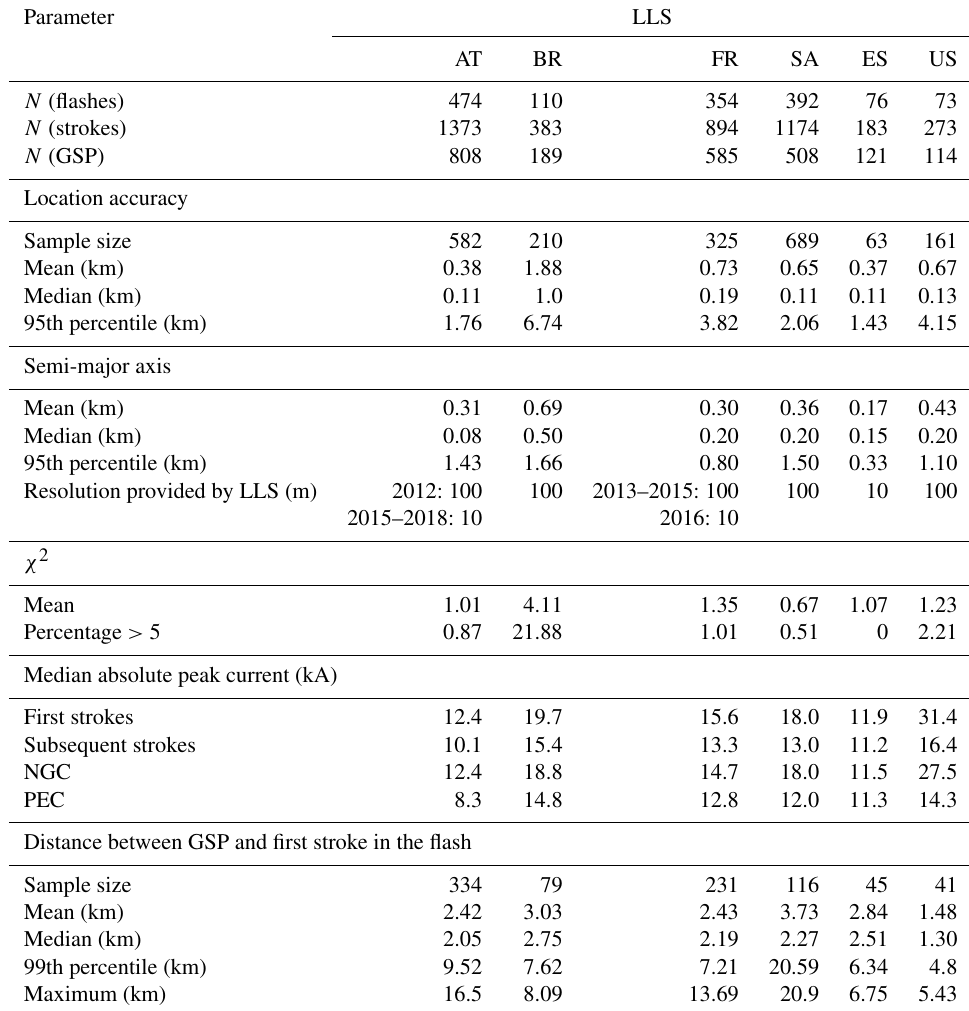
Table 1. Data set characteristics for Austria (AT), Brazil (BR), France (FR), South Africa (SA), Spain (ES) and the United States of Amer- ica (US). NGC is new ground contact point; PEC is pre-existing lightning